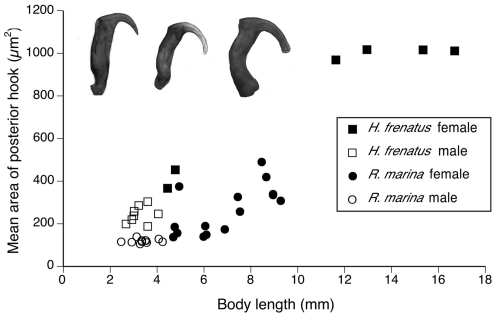
Area of posterior hook tips of Raillietiella frenatus graphed against pentastome body length.Small areas indicate relatively sharp hooks, large areas indicate relatively blunt hooks (see example pictures inset with sharp, intermediate and blunt hook tips).